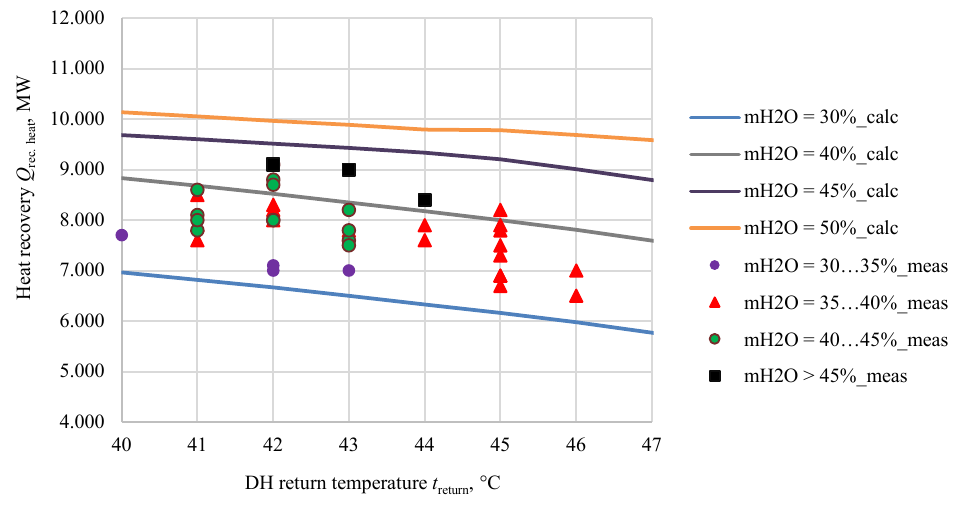
Fig. 1. Measured and calculated results, Mustamäe